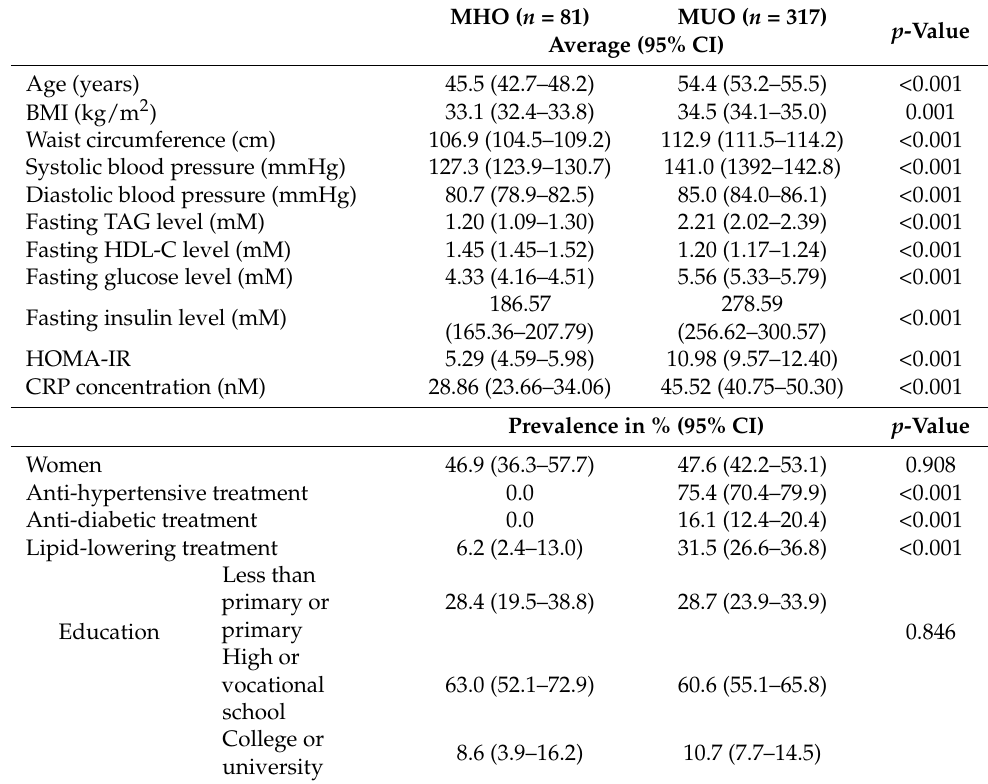
Table 1. Characteristics of obese participants by metabolically healthy and unhealthy